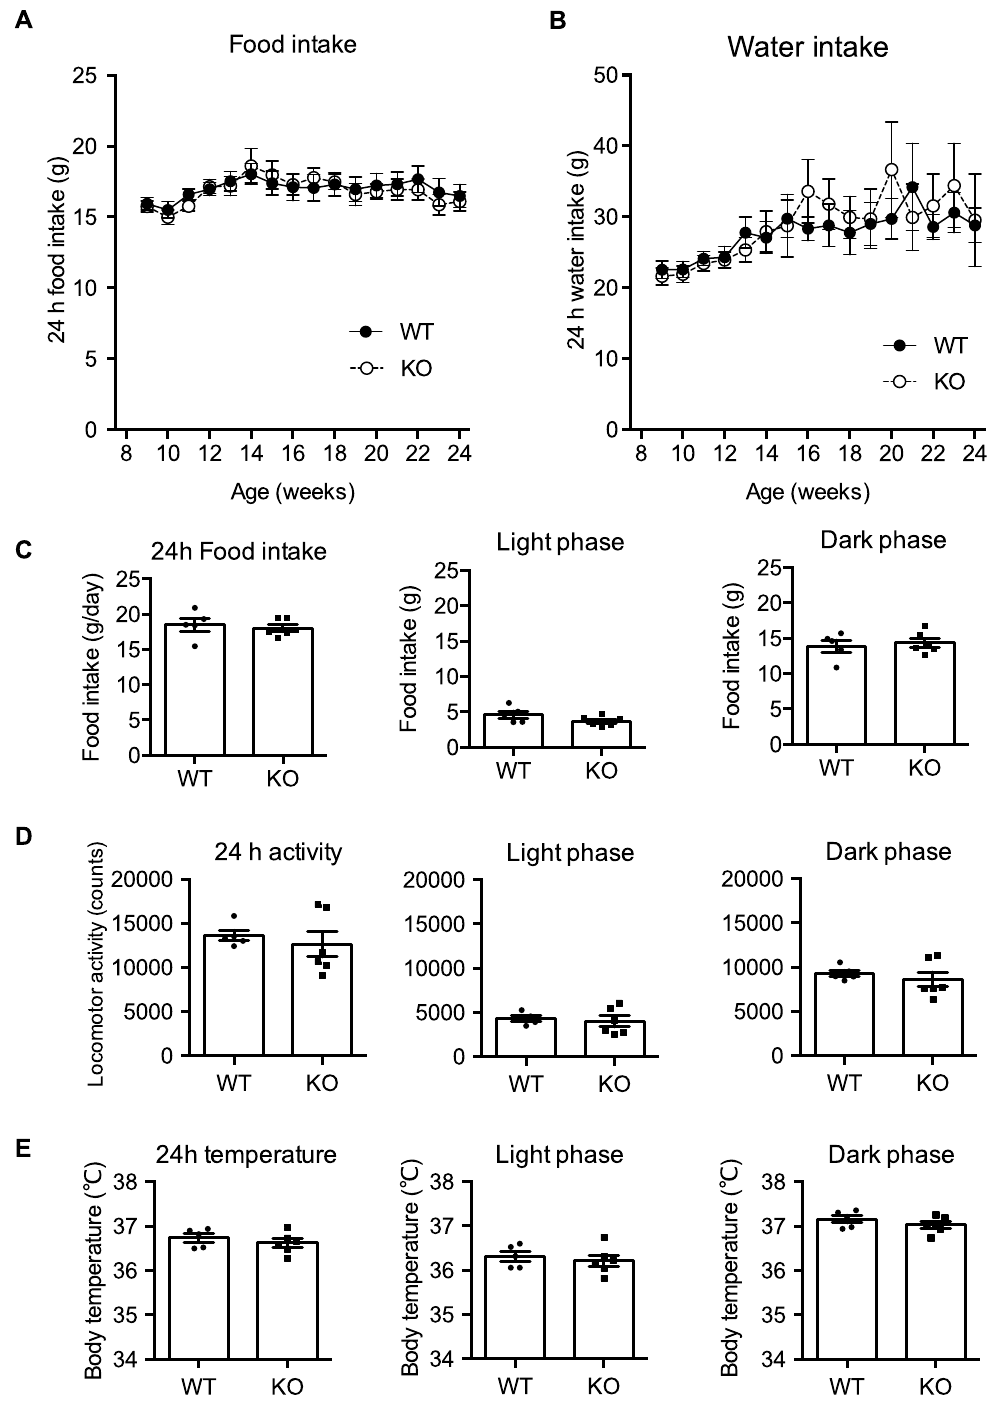
Figure 4. Food consumption, water intake, locomotor activity, and body temperature of male WT and NMU KO rats fed normal chow. ( A ) Food intake of free-feeding rats from 9 to 24 weeks of age (WT n = 22, KO n = 19). ( B ) Amount of water intake of free-feeding rats from 9 to 24 weeks of age (WT n = 22, KO n = 19). ( C ) Daily food consumption and feeding pattern at 14 weeks of age (WT n = 4, KO n = 5). ( D ) Counts of daily locomotor activity and activity pattern in the home cage (n = 5). ( E ) Mean body temperature over 24 h in light and dark phases (n = 5). All data represent means ±